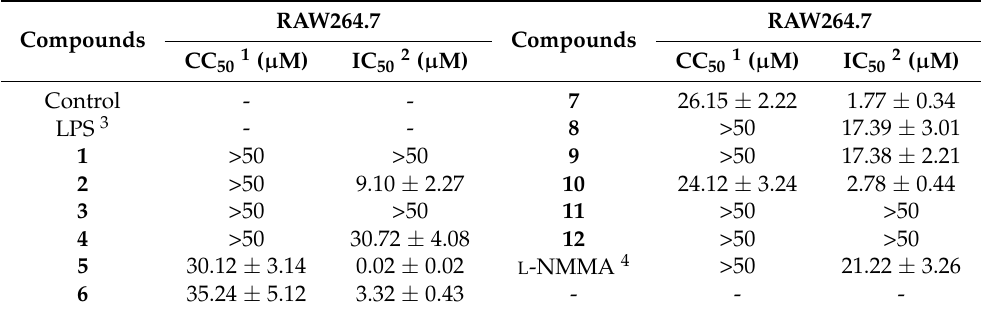
Table 3. Cell viability of RAW264.7 cells treated with compounds 1–12 and the NO inhibition activities on LPS-stimulated RAW264.7 (x ± s, n =